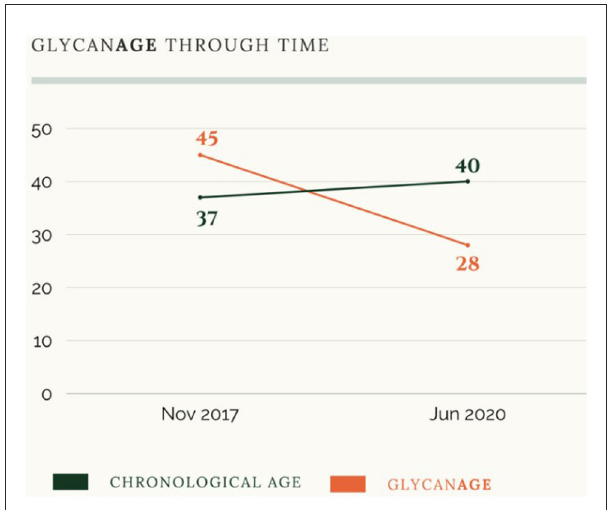
FIGURE1 Screenshot from the GlycanAge website illustrating a person’s biological age over time in comparison to their chronological age (November